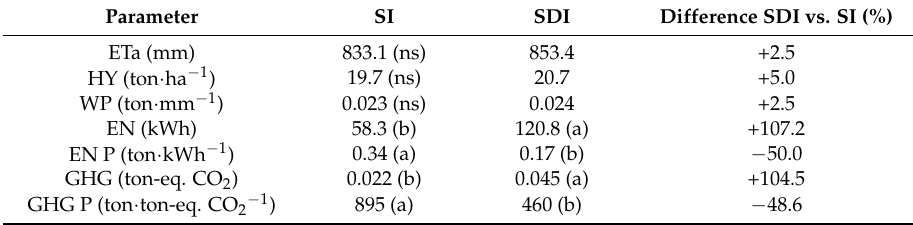
Table 1. Preliminary results on yield, water, energy and greenhouse gas emission footprints and productivities from the UCD–Russell Ranch